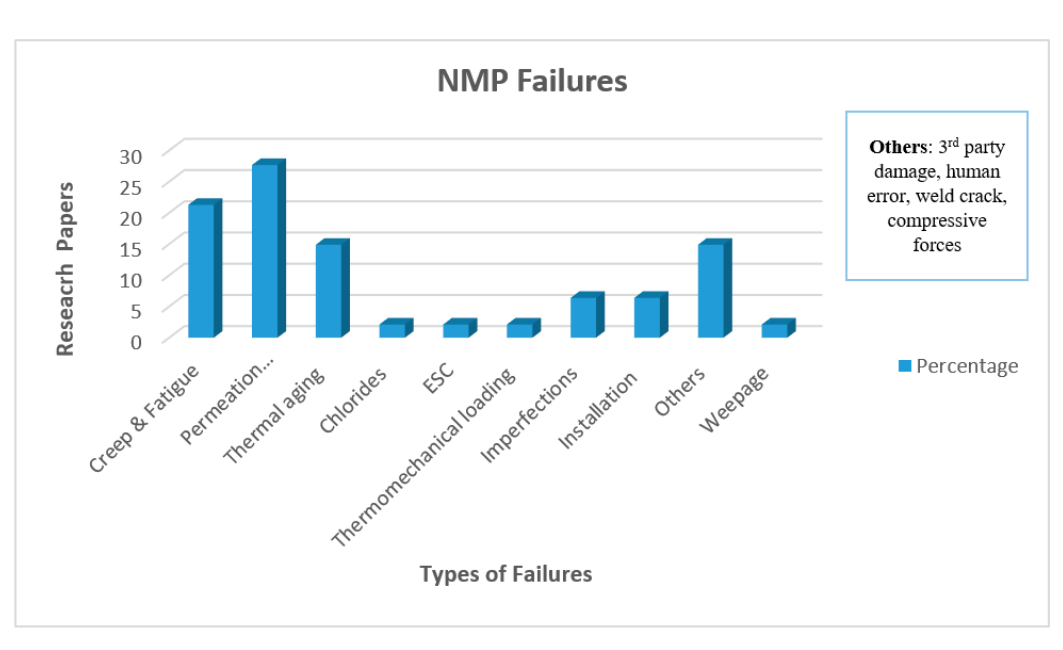
Figure 4. Failures in NMP material.